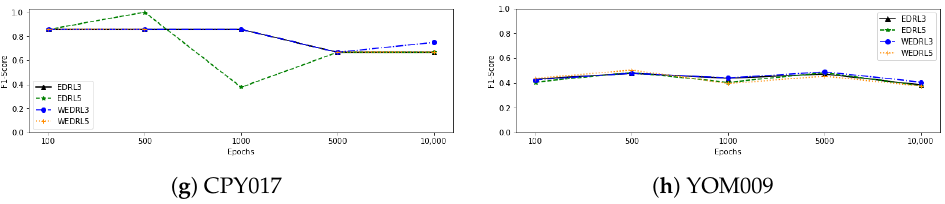
Figure 8. F1-score of ensemble model when increasing the learning epochs at CPY011, CPY012, CPY013, CPY014, CPY015, CPY016, CPY017, and YOM009 ( a – h ).